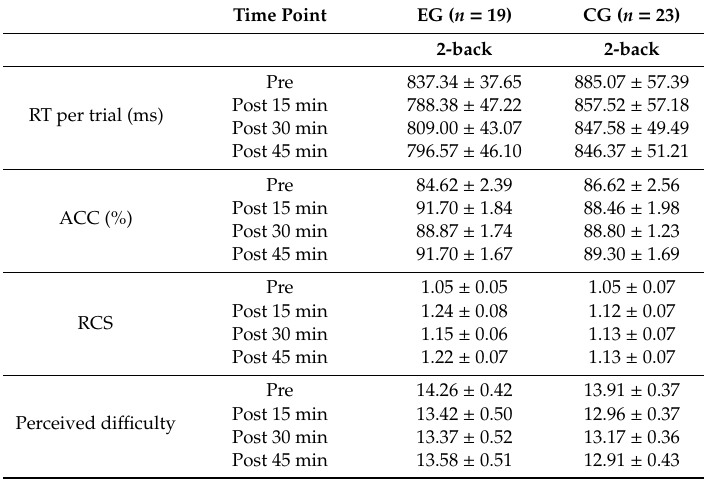
Table 2. Time course of 2-back task performance for the experimental (EG) and control group (CG). Time Point EG ( n = 19) CG ( n =